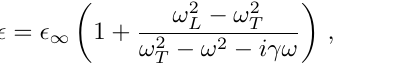
Figure 7: Total round-trip FP phase (cid:8) F (in the unit of π ) vs. wavelength at the perfect absorption angle of the shorter wavelength band ( θ = 34 . 7 ◦ , blue-solid) and the longer wavelength band ( θ = 40 . 7 ◦ ,